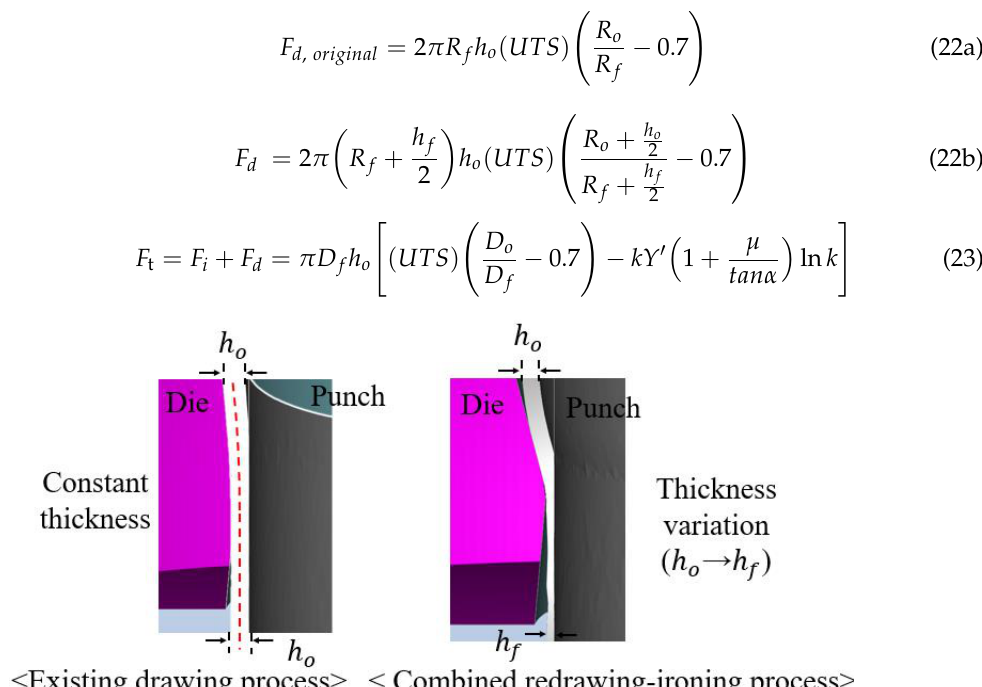
Figure 5. Thickness variation of the combined redrawing-ironing process in the 2nd stage.